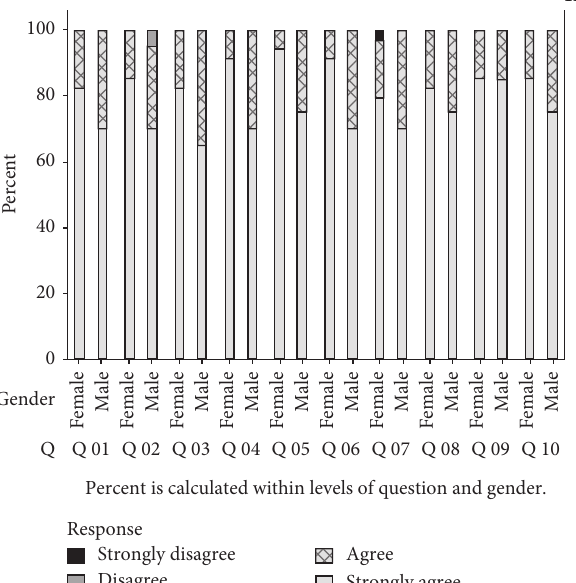
Figure 2: Comparison between the level of satisfaction between male and female patients regarding students’ performance.